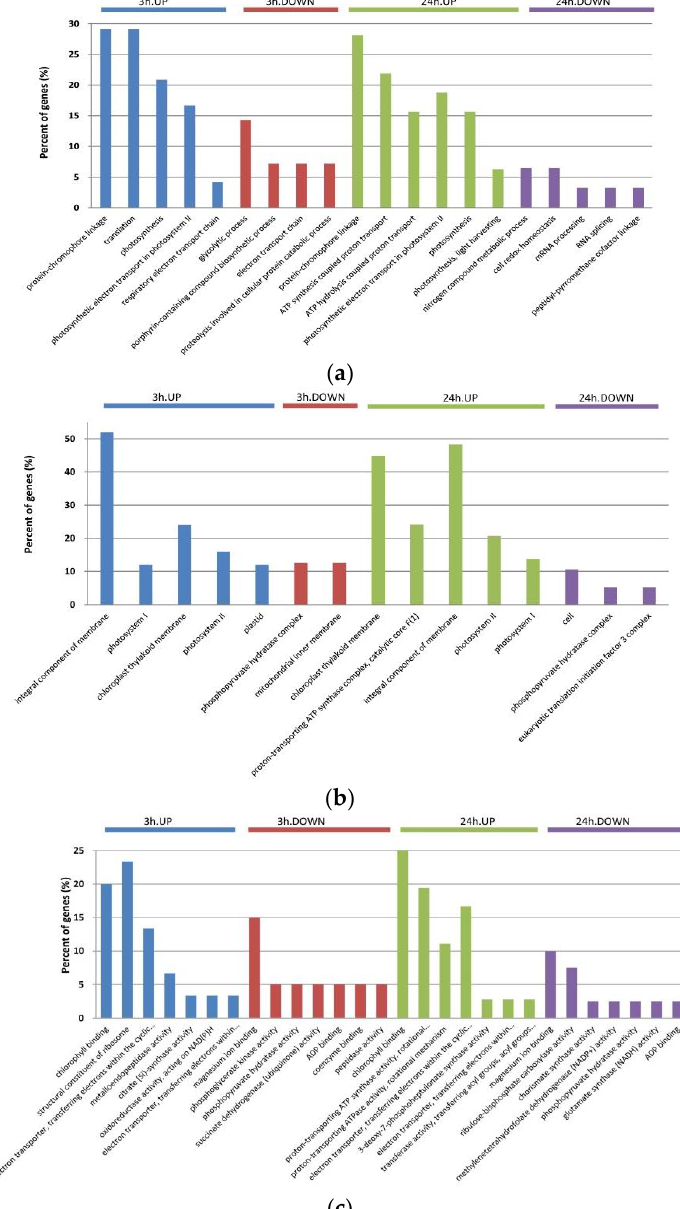
Figure 2. Gene ontology (GO) classification of the DAPs detected at each time point. GO terms in the biological process ( a ), cellular component ( b ), and molecular function ( c ) categories are presented.